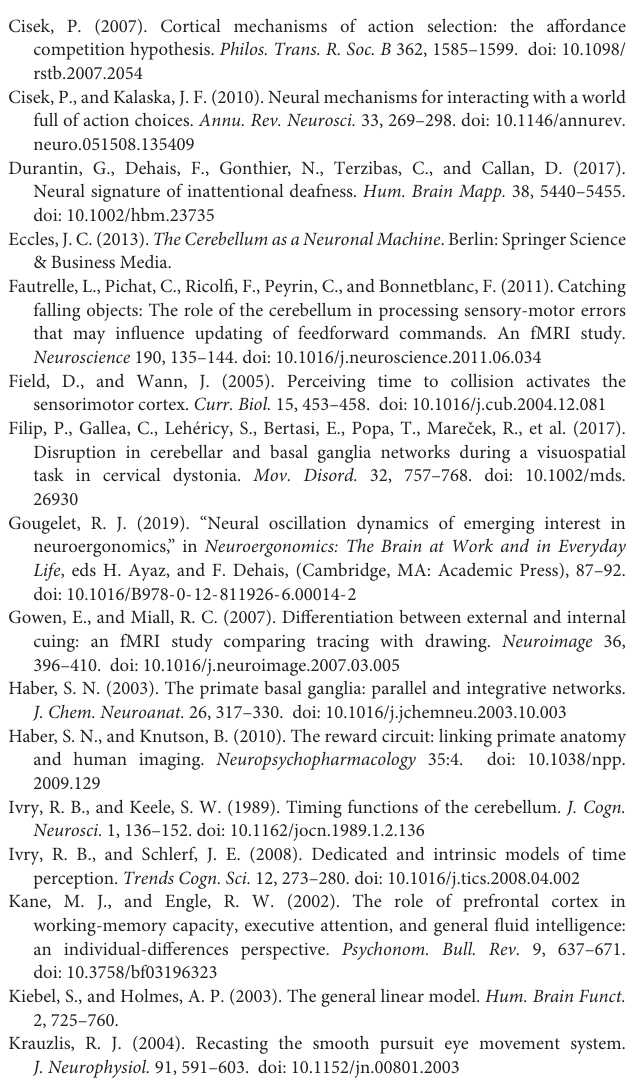
FIGURE S1 | Example design matrix. FIGURE S2 | Null result – IX auditory task × negative distance. FIGURE S3 | Null result – IX auditory task × negative performance. FIGURE S4 | Null result – IX auditory task × positive distance. FIGURE S5 | Null result – IX auditory task × positive performance. FIGURE S6 | Significant result – negative distance – Figure 3 . FIGURE S7 | Significant result – negative performance – Figure 2A . FIGURE S8 | Null result – positive distance. FIGURE S9 | Significant result – positive performance – Figure 2B